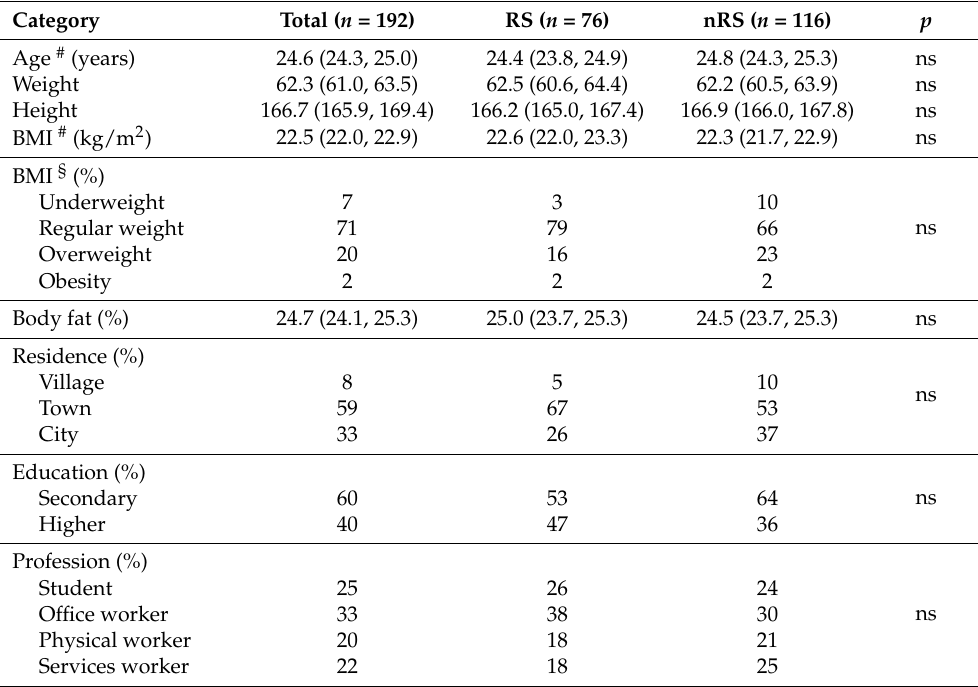
Table 1. Sample characteristics ( n =